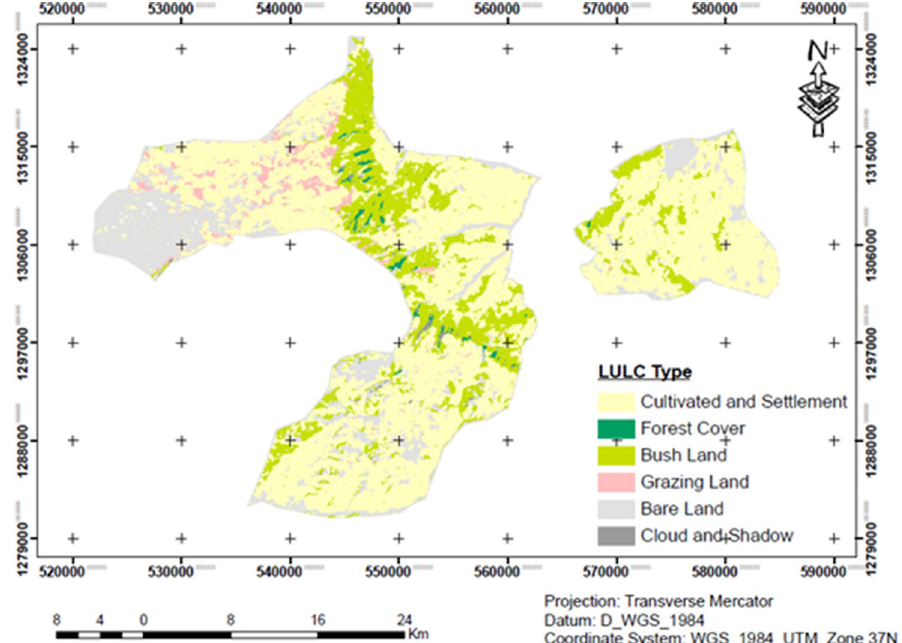
Fig. 4 LULC map of Gubalafto District in 2016